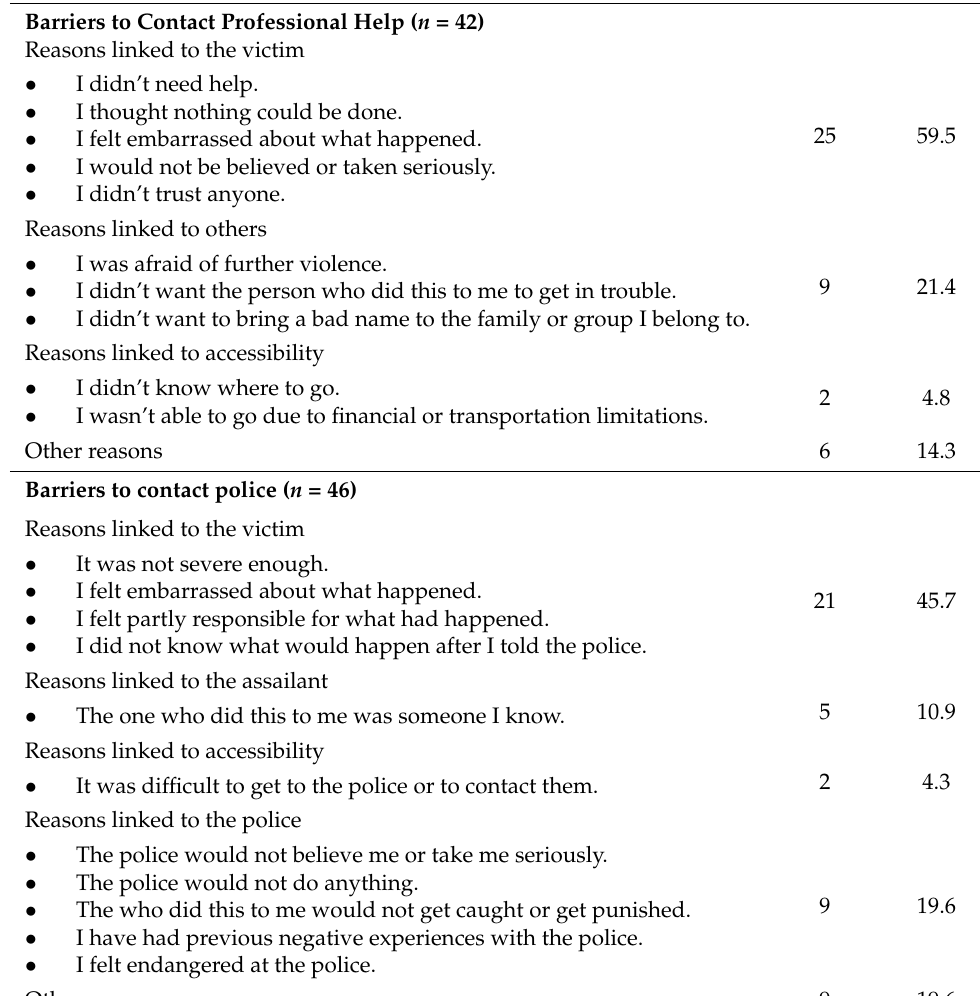
Table 8. Barriers for help-seeking after sexual victimization. Item n % Barriers to Contact Professional Help ( n =